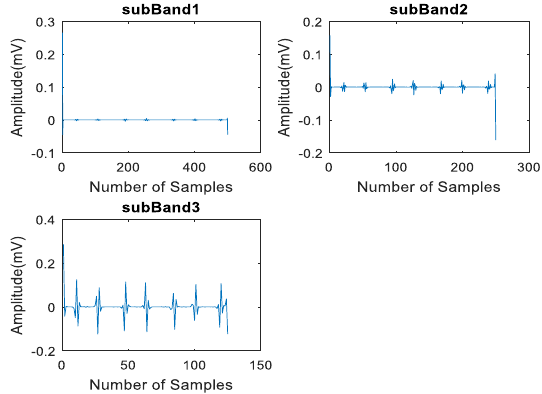
Fig. 5. The sub bands of the ECG signal for Tree A.